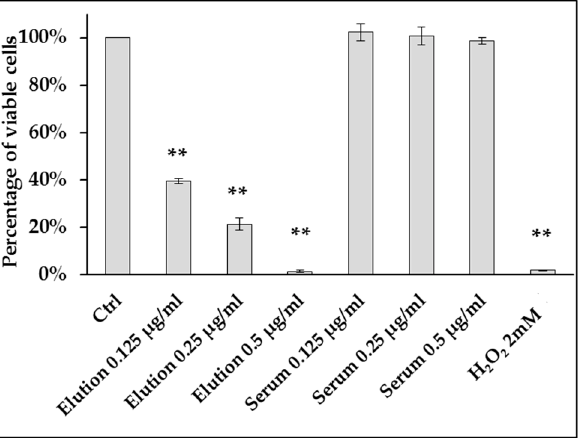
Figure 1. Changes in cell viability of HAECs treated with different concentrations of proteins isolated from polymer matrix (CTB-assay) (n = 3). Cells treated with increasing concentrations of eluted proteins (0.125 µg/mL, 0.25 µg/mL, 0.5 µg/mL) for 24 h, have demonstrated a dramatic drop in the rate of metabolism compared to untreated control (** p < 0.001, t -test).